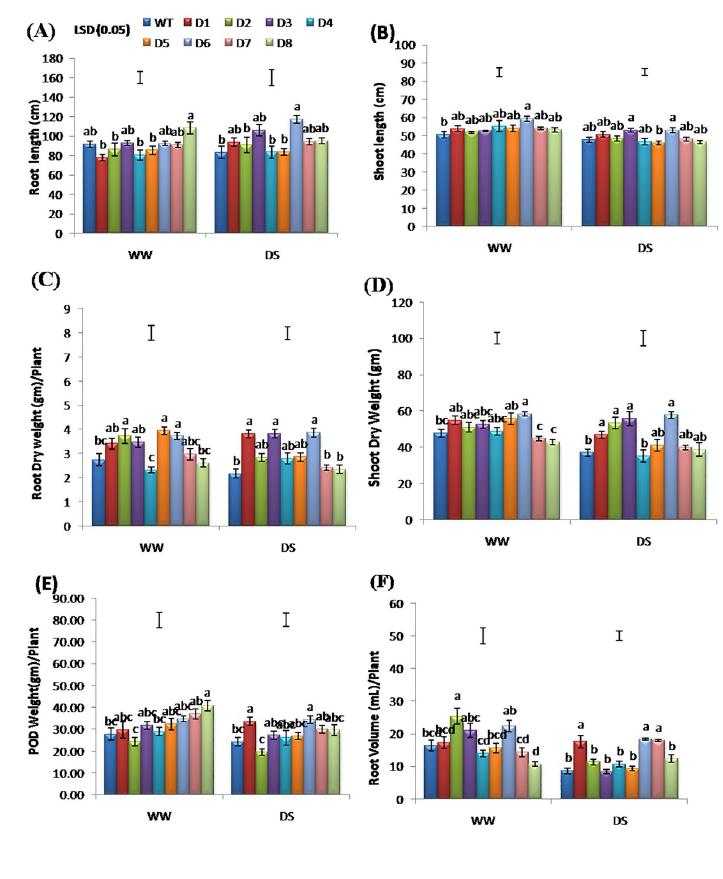
Fig 5. Comparison of various growth parameters in WT and T lines under DS (after 25 days of DS imposition) and WW conditions. Where (A) Root-length, (B) Shoot-length, (C) Root-mass, (D) Shoot-mass, (E) Pod-mass, (F) Root-volume, from WT (GG 20) and eight independent T lines (D1-D8) after harvesting (120 day old plants with maturity).